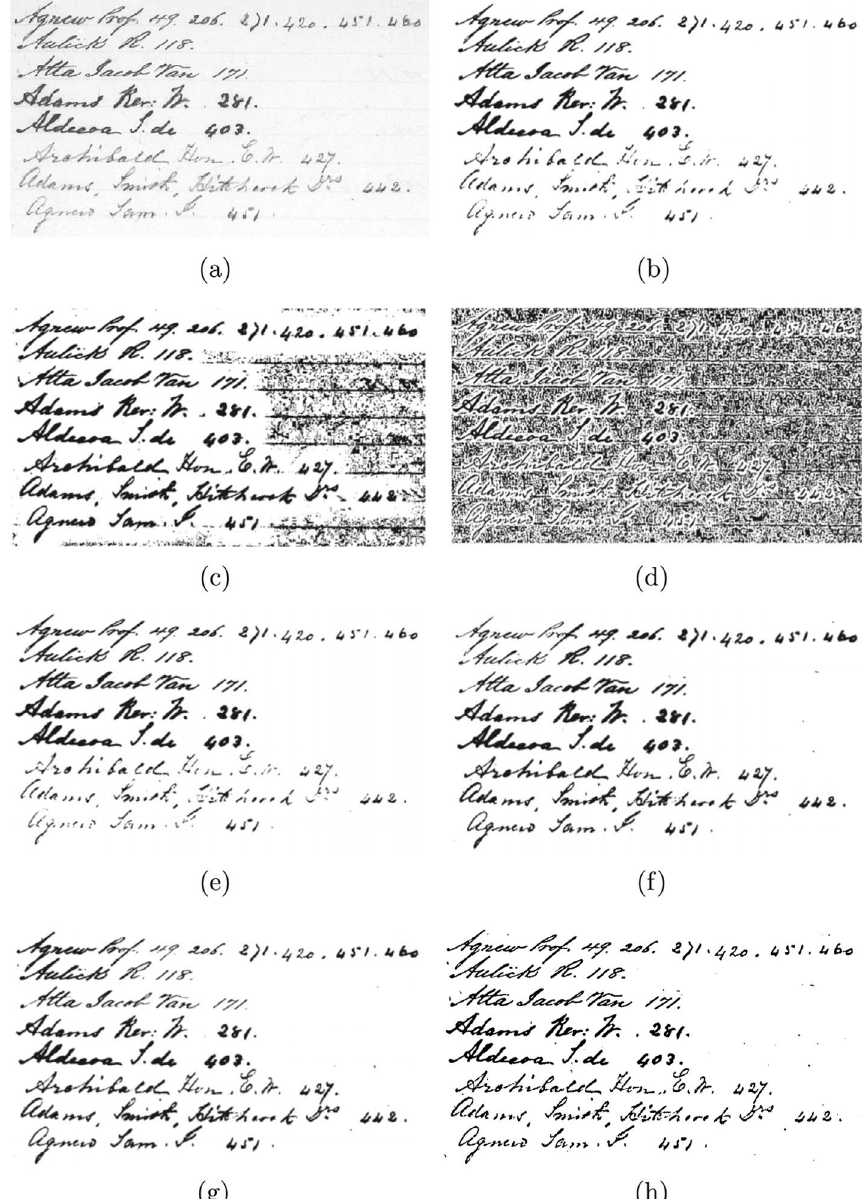
Fig. 10 Binarization results of a sample image by different methods. a Original image, b Otsu [3], c Niblack [5], d Bernsen [4], e Sauvola [6], f Singh [8], g Lu [9], and h proposed